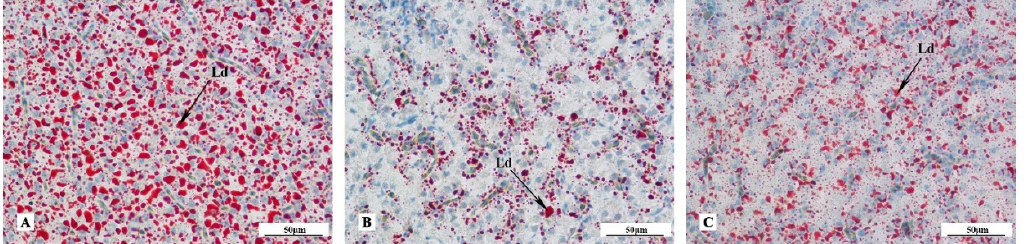
Figure 2. Oil Red O staining of liver tissues of GIFT fed with different ASW concentrations. Magnification 200×. ( A ) Fish fed the diet with no ASW; ( B ) fish fed the diet with 0.4‰ ASW; ( C ) fish fed the diet with 1.6‰ ASW. Ld: Lipid droplet. Table 7. Effect of ASW on the area of hepatic lipid droplets in GIFT (mean ± SEM). ASW (‰) 0 0.4 Lipid droplet (Object/Total, %) * Different superscript lowercase letters in the same row indicate a significant difference ( p < 0.05).